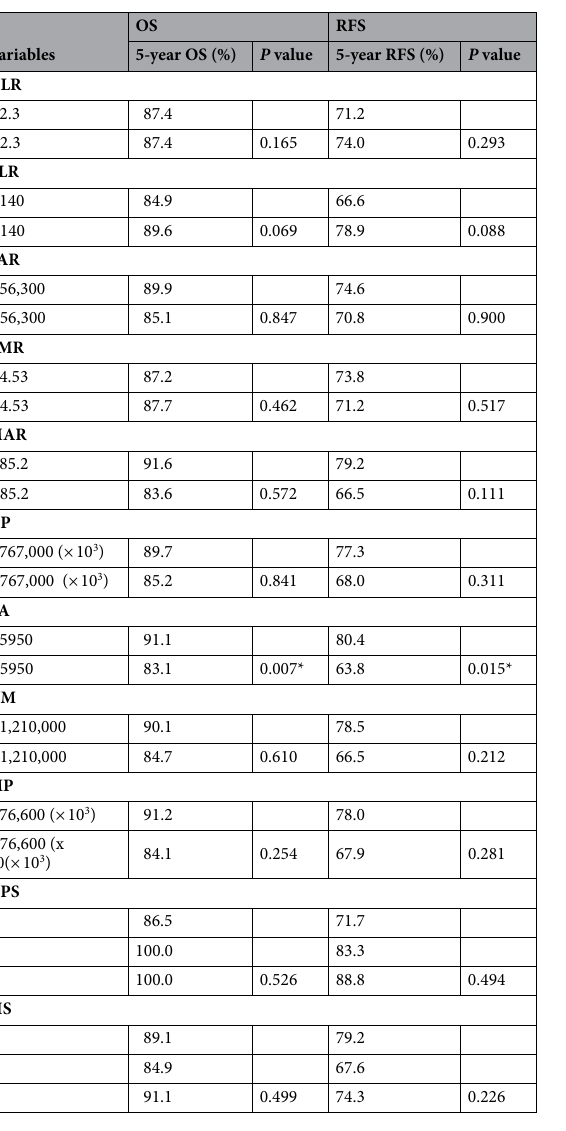
Table 2. The relationships between inflammation-related markers (the 9 combinations and 2 scoring systems) and survival. NLR neutrophil-to-lymphocyte ratio, PLR platelet-to-lymphocyte ratio, PAR platelet-to-albumin ratio, LMR lymphocyte-to-monocyte ratio, MAR monocyte-to-albumin ratio, NP neutrophil × platelet, LA lymphocyte × albumin, NM neutrophil × monocyte, MP monocyte × platelet, GPS Glasgow prognostic scale, SIS systemic inflammation scale. * P <